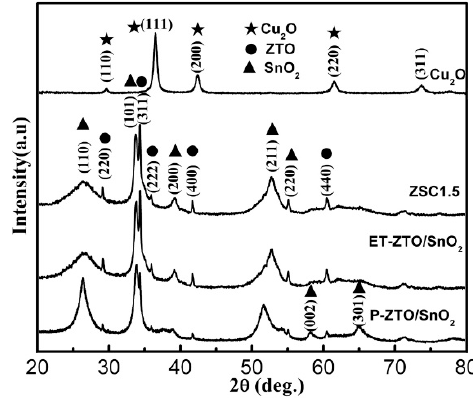
/ SnO 2 , ET-ZSO 2 , ZSC1.5, and Cu 2 O